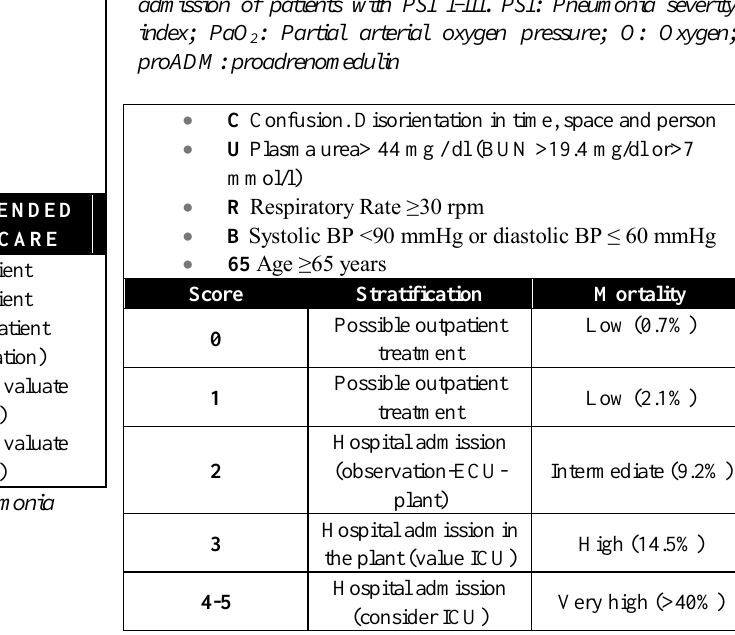
Table 9: CURB-65 Scale. In the case of the existence of any of the additional criteria indicated in Table 7, even with CURB-65 score of 0-1, the patient should be